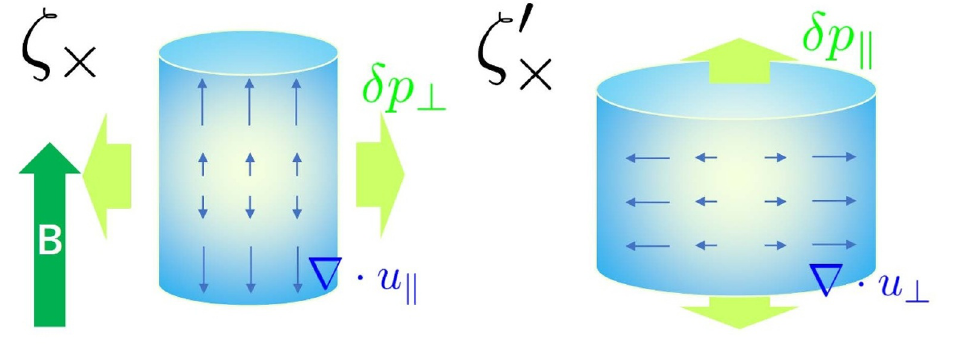
Figure 4 . Cross bulk viscosities that are the response of the pressure (green arrows) in the orthogonal direction to the expansion/compression (blue arrows) of the system (compare with figure 3). Those two cases are reciprocal processes to each